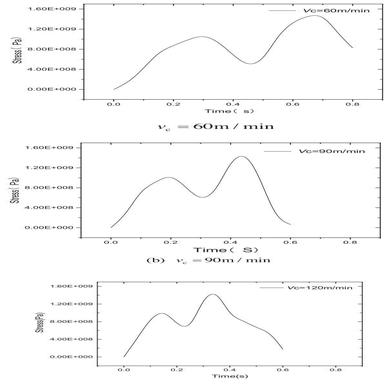
The stress variation curves of a unit in the first deformation zone.